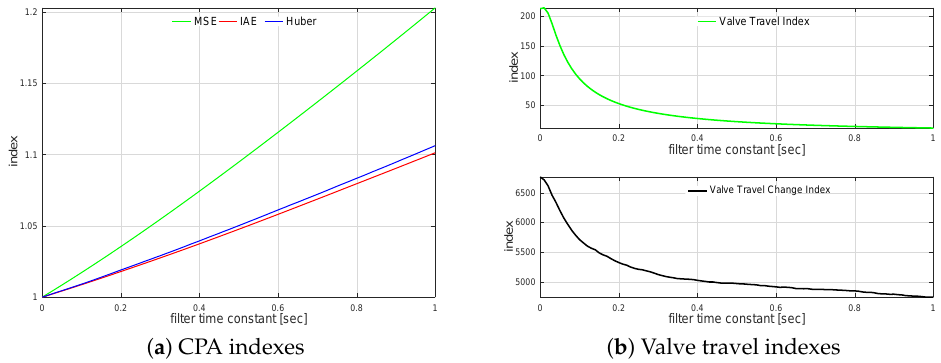
Figure 10. Control error filtering relationships for G 4 ( s )